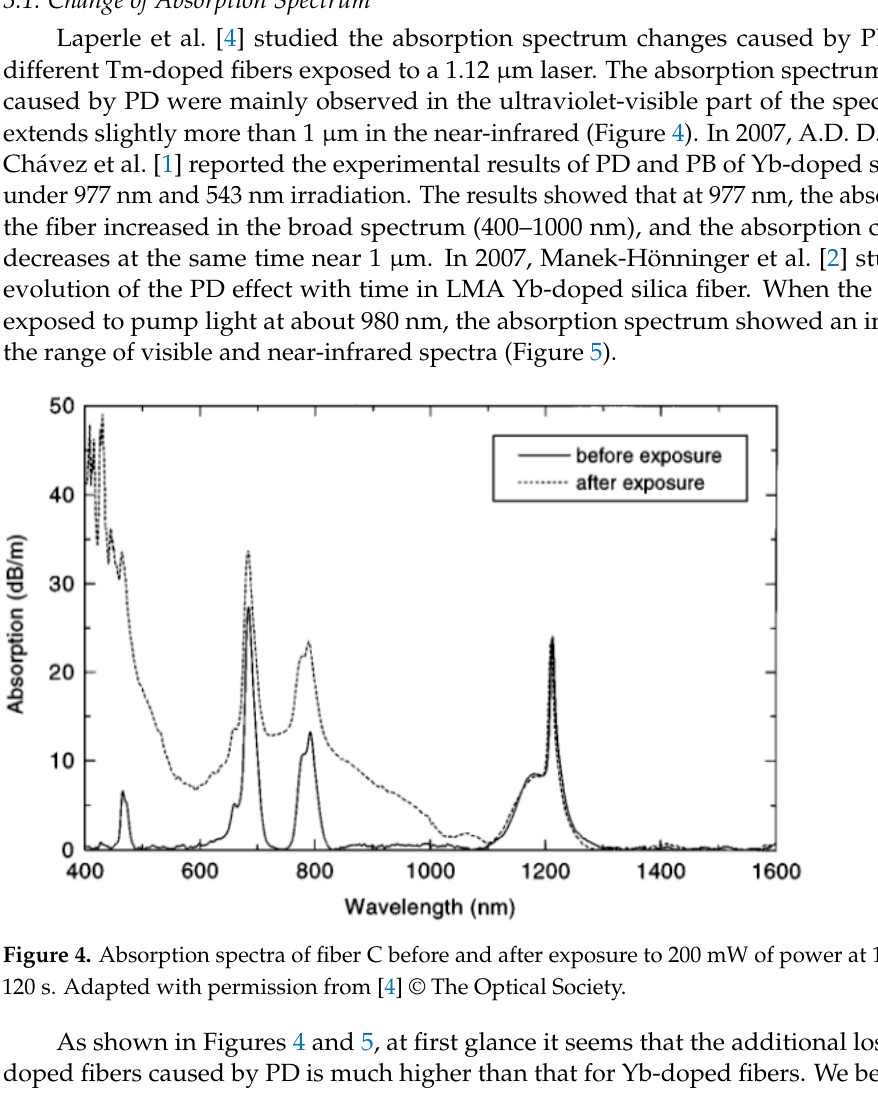
Figure 5. Absorption spectra of an unphotodarkened LMA Yb-doped fiber (red curves) and of the same fiber at different states of PD at 7 min, 15 min, and 100 min (orange, green, and blue) of pumping the fiber by the light of 45 W at 976 nm. Adapted with permission from [2] © The Optical Society. As shown in Figures 4 and 5, at first glance it seems that the additional loss for Tm- doped fibers caused by PD is much higher than that for Yb-doped fibers. We believe that there are two reasons why it is easier for Tm-doped fiber to generate PD than Yb-doped fiber. First of all, the energy structure of the Tm ion is more prone to the upconversion phenomenon, which produces high-energy photons to excite color centers. Secondly, their experimental conditions are different. For example, The Tm-doped fiber is core- pumped and the Yb-doped fiber is cladding-pumped in the above two experiments, which means that core-pumping can lead to higher pump energy densities for generat- ing PD.